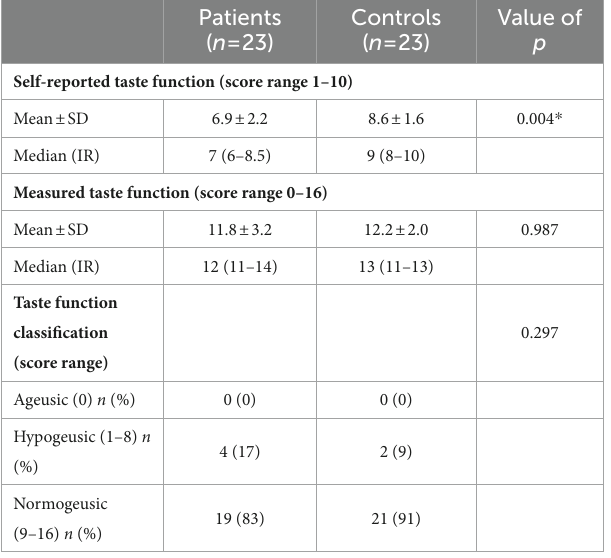
TABLE 7 Results and classification of taste function